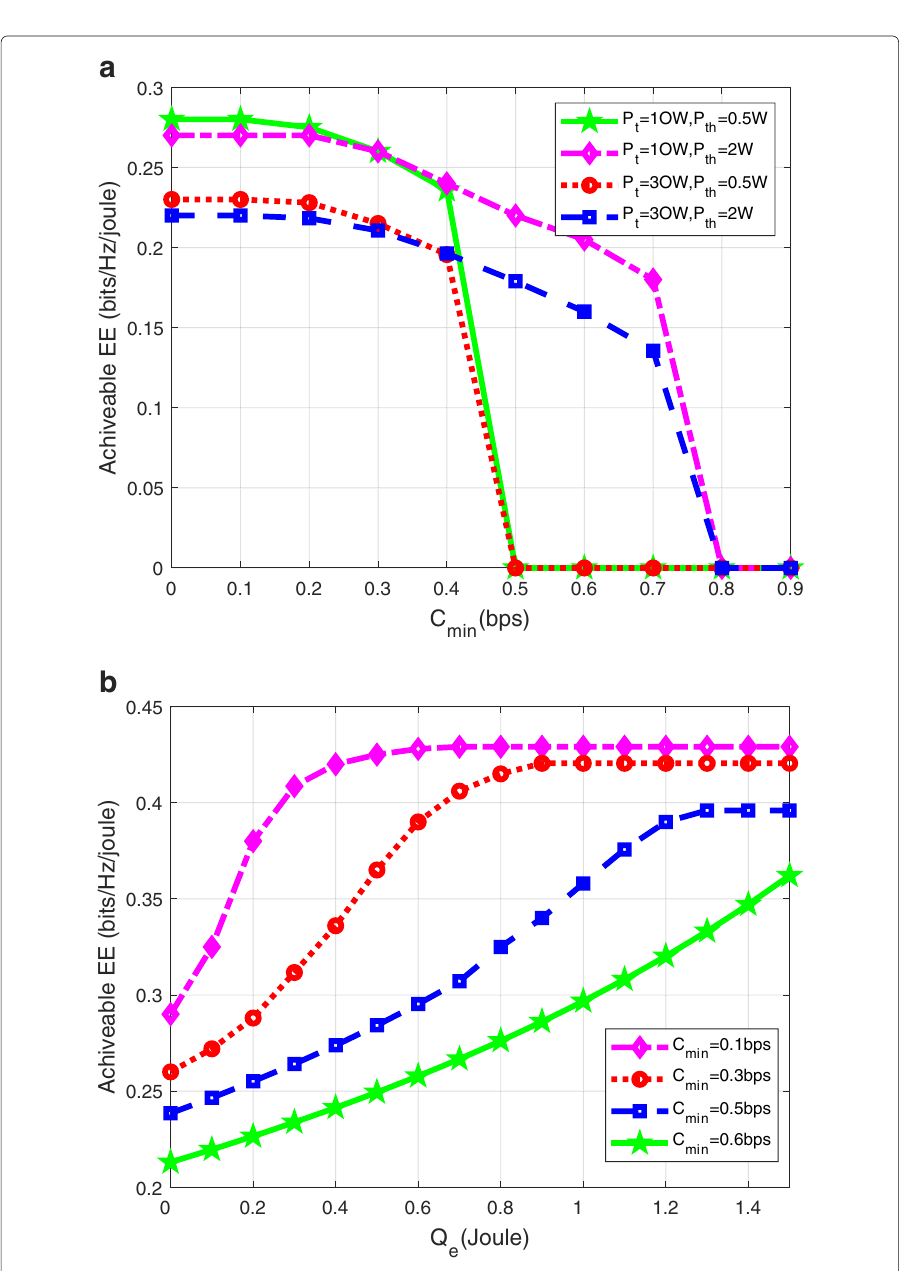
Fig. 3 Comparison of expected EE performance under different C min and Q e constraints . a Expected EE versus C min with Q e = 0. b Expected EE versus Q e with P t = 10W and P th =